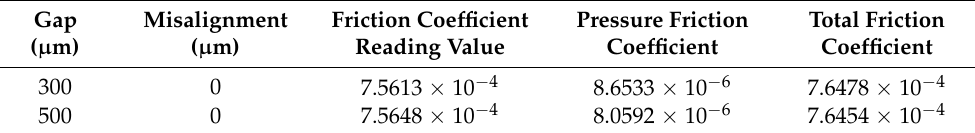
Figure 6. The velocity distributions of the friction sensor with a different gap ( a ) 300 µ m and ( b ) 500 µ m, and the surface friction coefficient program of the sensor with a different gap ( c ) 300 µ m and ( d ) 500 µ m. Table 2. The total friction coefficient of the sensors with a different gap in laminar